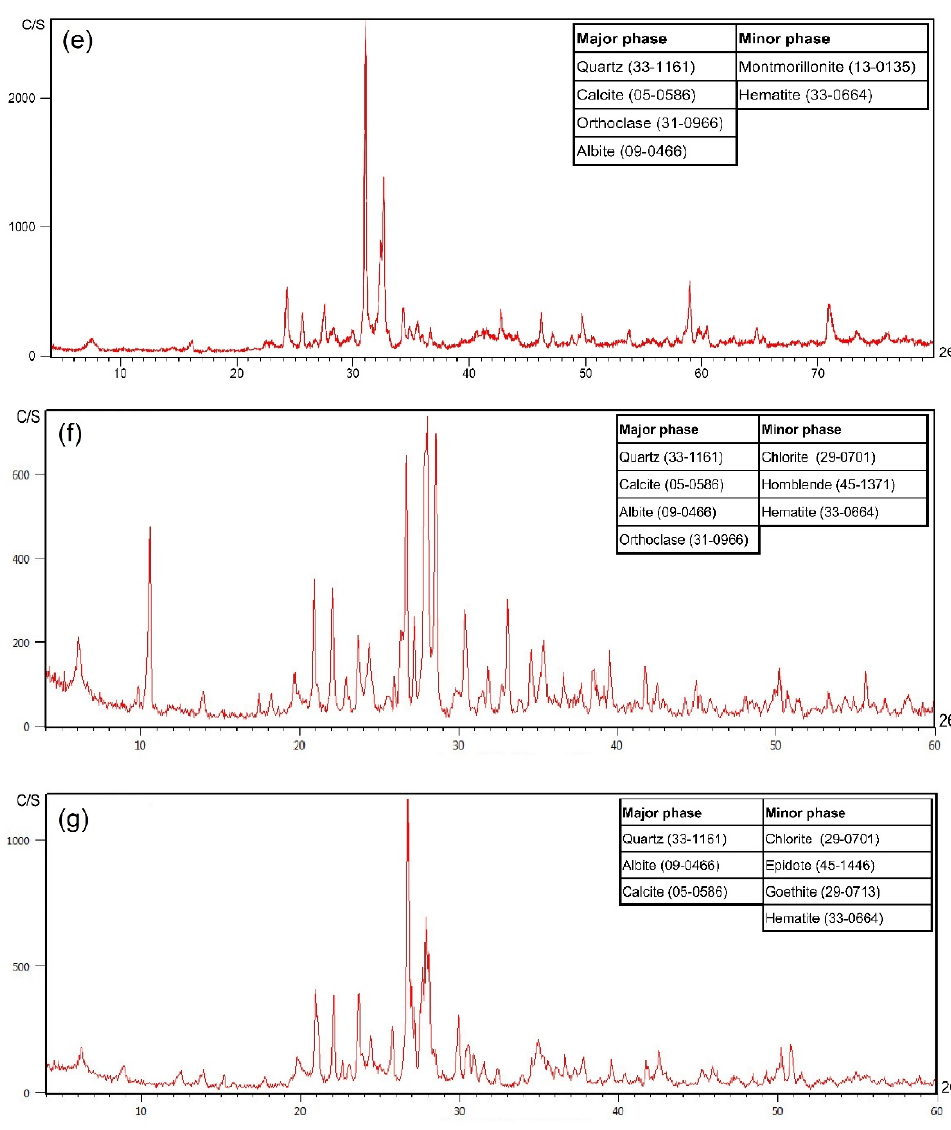
Figure 13. The XRD analysis of ( a ) the S04, ( b ) S07, ( c ) S13, ( d ) S19, ( e ) S21, ( f ) S14, and ( g ) S16 samples. The XRD results of ( a , b ) show peaks of phyllic alteration. ( c , d ) show peaks of phyllic–argillic alteration minerals. The XRD in ( e ) shows argillic alteration. The peaks in ( f , g ) indicate that samples S14 and S16 were collected from propylitic alteration. The C/S means Count per second is y title and 2 Ѳ is the x